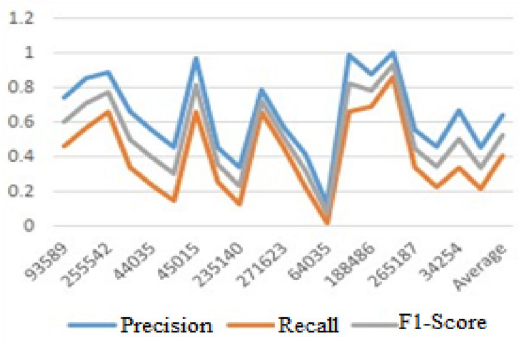
Figure 2. Experimentation value based on individual user similarity.